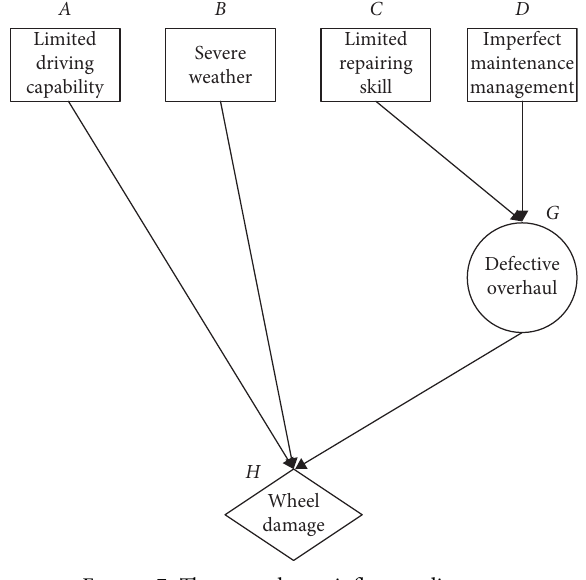
Figure 7: The second step influence diagram.